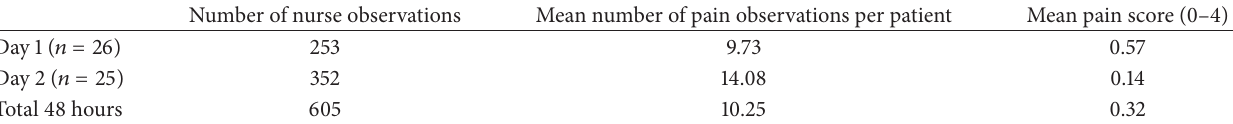
Table 3: The total number and average number per patient of pain observations taken in the standard group and mean pain score recorded.